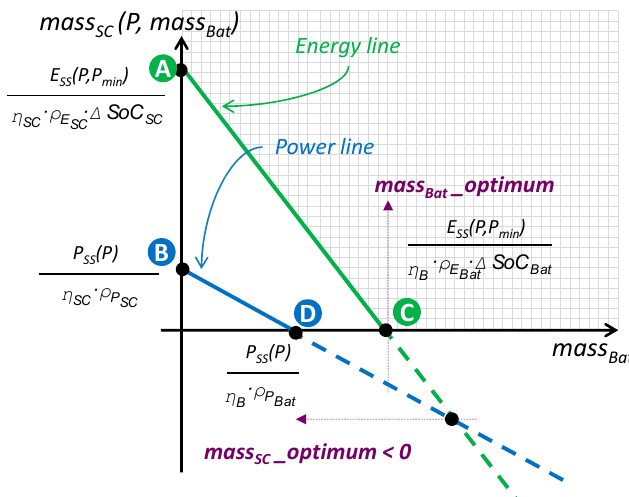
Figure 5. Equations system graphic solution in the fourth quadrant.